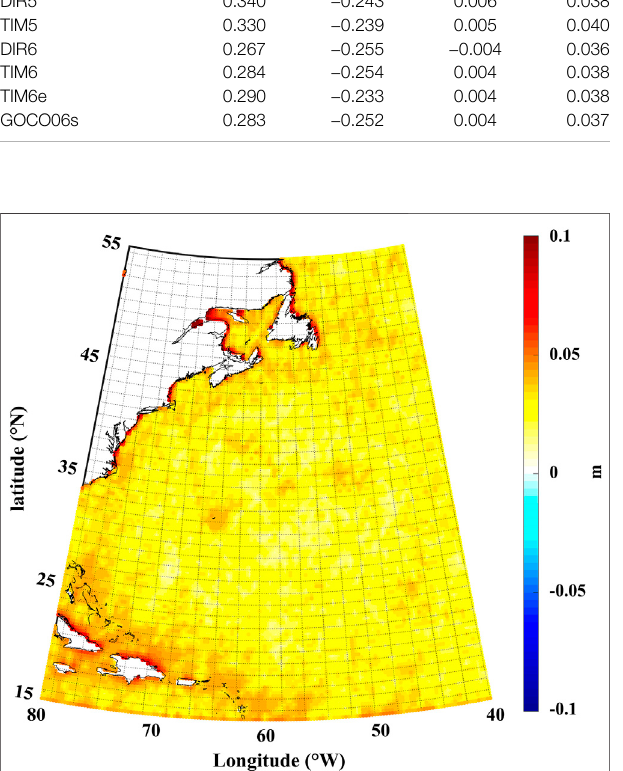
FIGURE 5 | Estimated errors based on DIR6 with cs 1 of d/o 260.